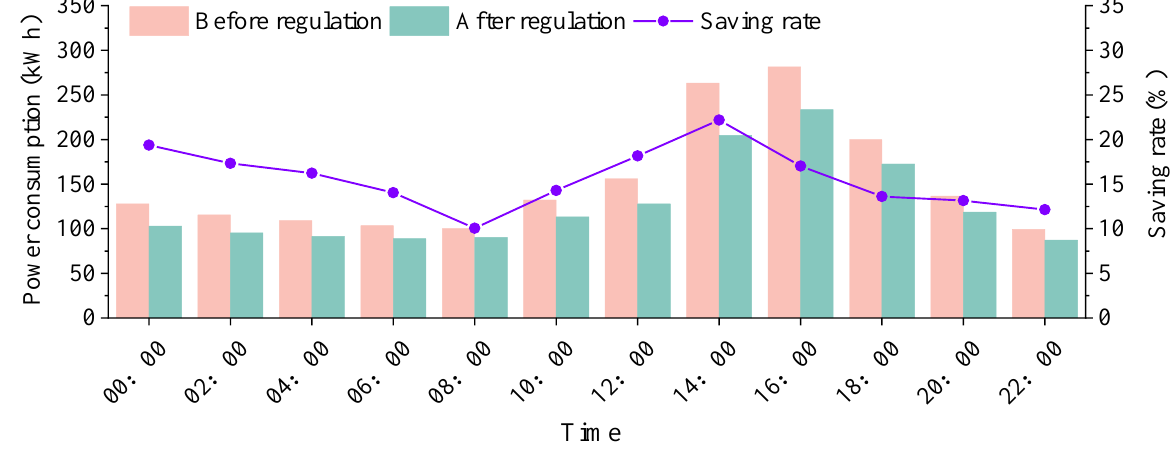
Figure 15. Comparison of corrected power consumption of circulating water pump in secondary network based on two operational strategies.